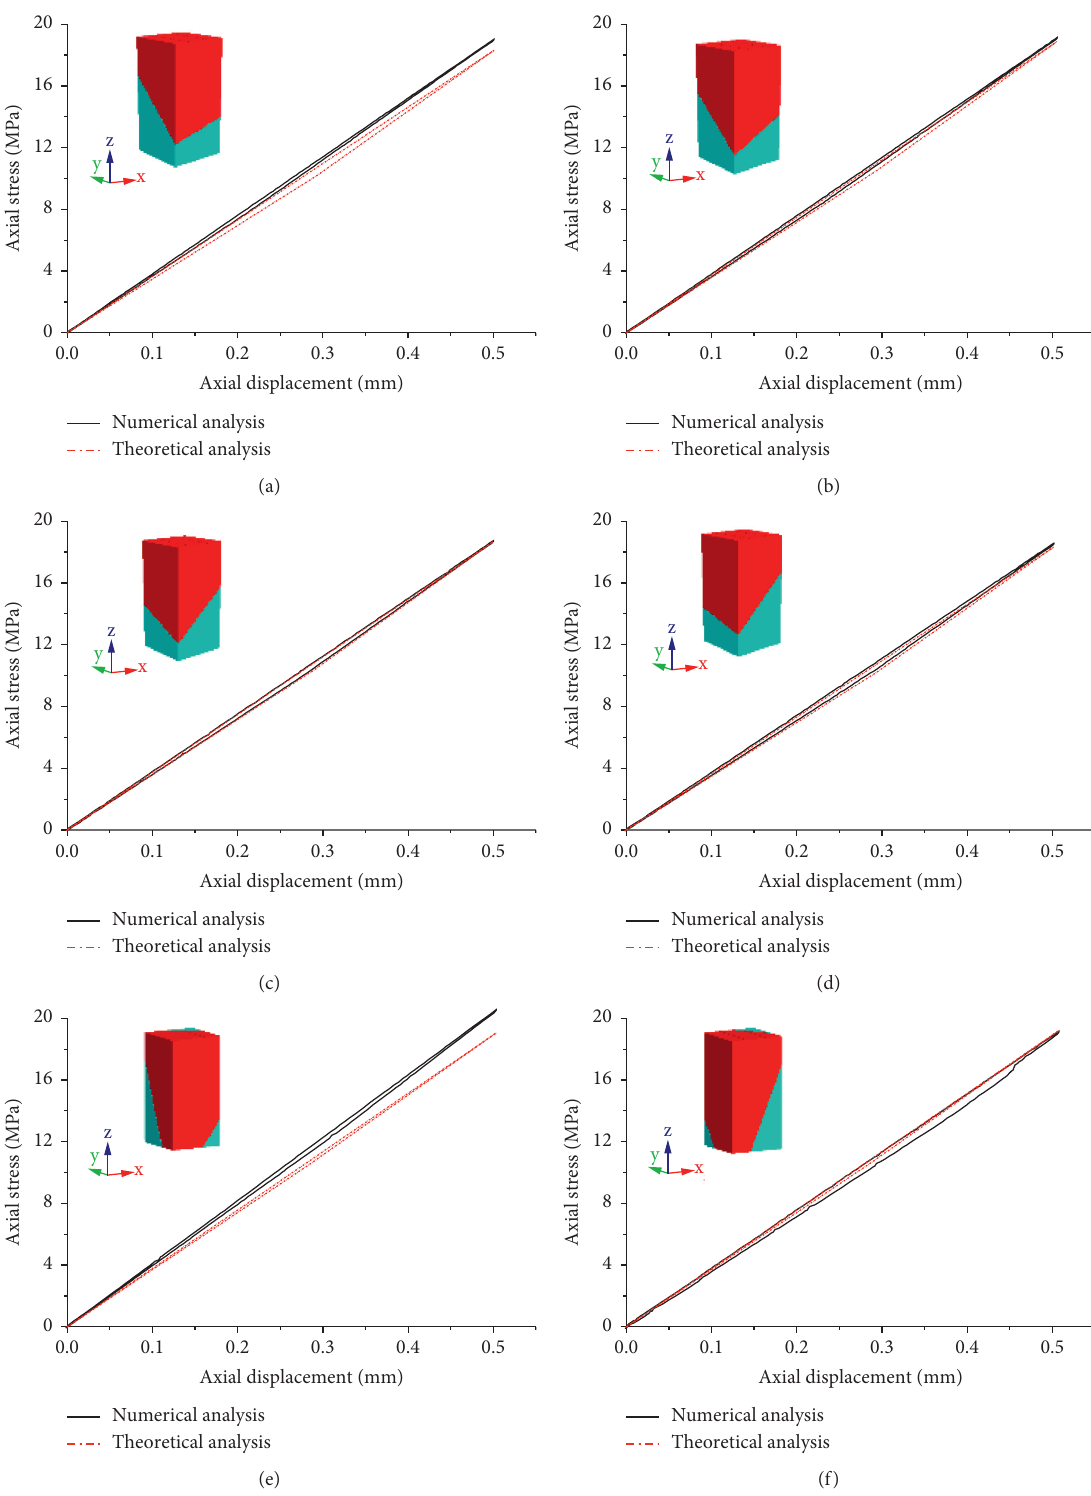
Figure 3: Comparison of numerical and theoretical results at different azimuth angles (a) α � 45 ° and β � 15 ° . (b) α � 45 ° and β � 30 ° . (c) α � 45 ° and β � 60 ° . (d) α � 45 ° and β � 75 ° . (e) α � 70 ° and β � 30 ° . (f) α � 70 ° and β � 60 °